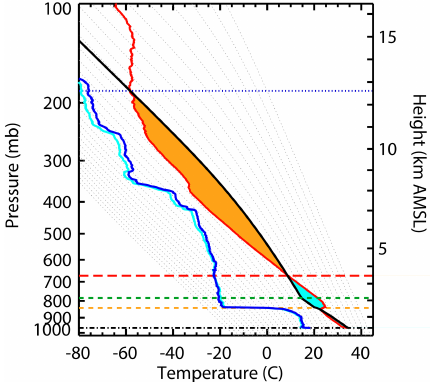
Figure 6. Graphical representation of convective indices. Central Facility radiosonde profile for 11 May 2011 02:34UTC graphically illustrating the convective indices of CAPE (orange shading) and CIN (cyan shading) and relevant buoyancy levels including the lift- ing condensation level (LCL, green dashed), level of free convec- tion (LFC, red dashed) and equilibrium level (blue dotted). The en- vironmental virtual temperature profile is shown by the solid red line, adiabatic virtual parcel temperature is shown by the solid black line, the observed dew point temperature profile is shown with the dark blue line and the RH-corrected dew point temperature profile is shown with the cyan